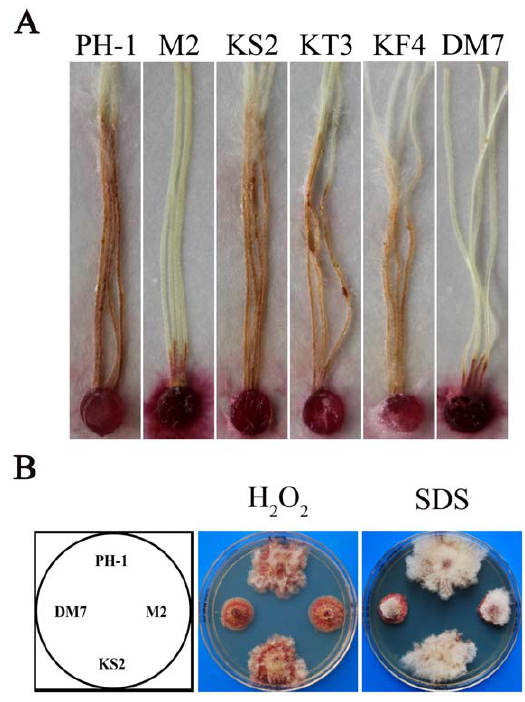
Figure 7. Infection assays and stress response tests with mutants deleted of other PRMT genes. A . Corn silks inoculated with the wild type (PH-1), M2 ( D amt1 ), KS2 ( D amt2 ), KT3 ( D amt3 ), KF4 ( D amt4 ), and DM7 ( D amt1 D amt2 ). B . Colonies of PH-1, DM7, M2, and KS2 grown on PDA plates with 0.05% H 2 O 2 or 0.01% SDS.